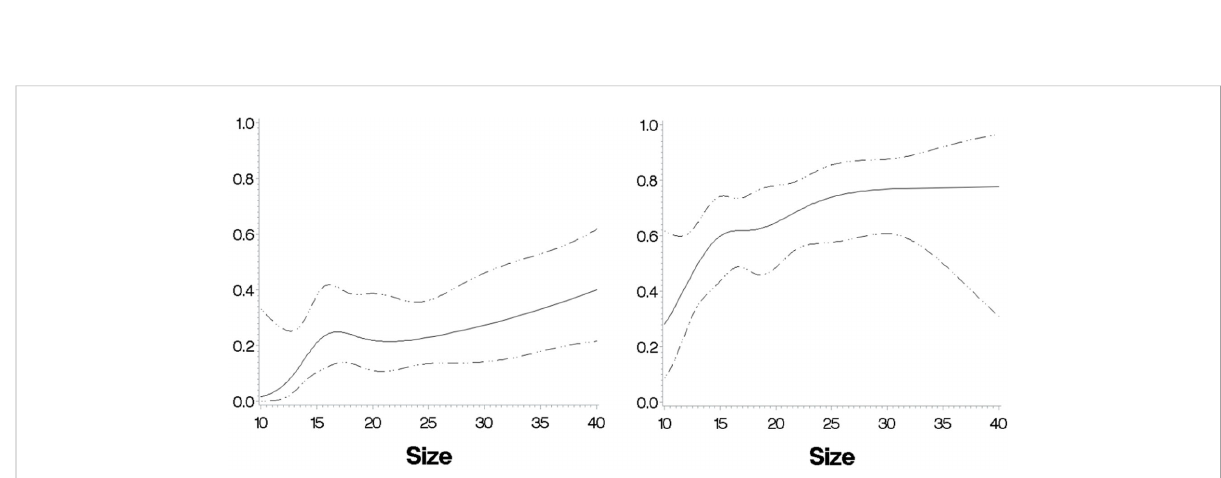
FIGURE 9 The predicted probabilities for cortisol DST to be ≥ 50 nmol/L in relation to size in two patient groups with a respectively low and high probability based on their ages, BMI, and eGFR. Left panel: patients with unilateral AIs, age <63 years, eGFR of ≥ 80 ml/min/1.73 m 2 , and BMI of ≥ 28 kg/m 2 ( n = 138). The probability for cortisol DST ≥ 50 nmol/L is below 10% in patients with AIs 10 – 12 mm in size and approximately 30% in patients with AIs larger than 30 mm. Right panel: patients with unilateral AIs, age ≥ 63 years, eGFR of 30 – 80 ml/min/1.73 m 2 , and BMI of <28 kg/m 2 ( n = 151). The probability for cortisol DST ≥ 50 nmol/L is approximately 30% in patients with AIs 10 – 12 mm in size and approximately 70% in patients with AIs larger than 30 mm. The fi gures are calculated with restricted cubic splines and are not adjusted for age, BMI, and